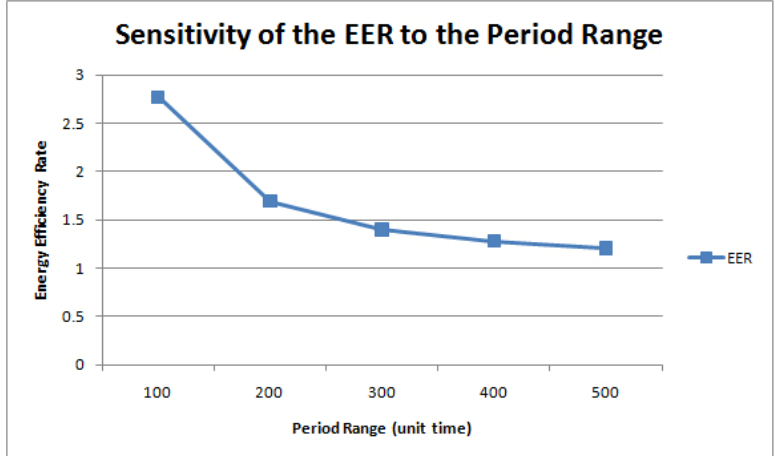
Figure 16. Sensitivity of the EER to the period